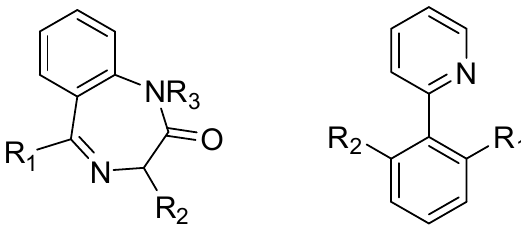
Figure 1. Readily accessible diversifiable scaffolds.